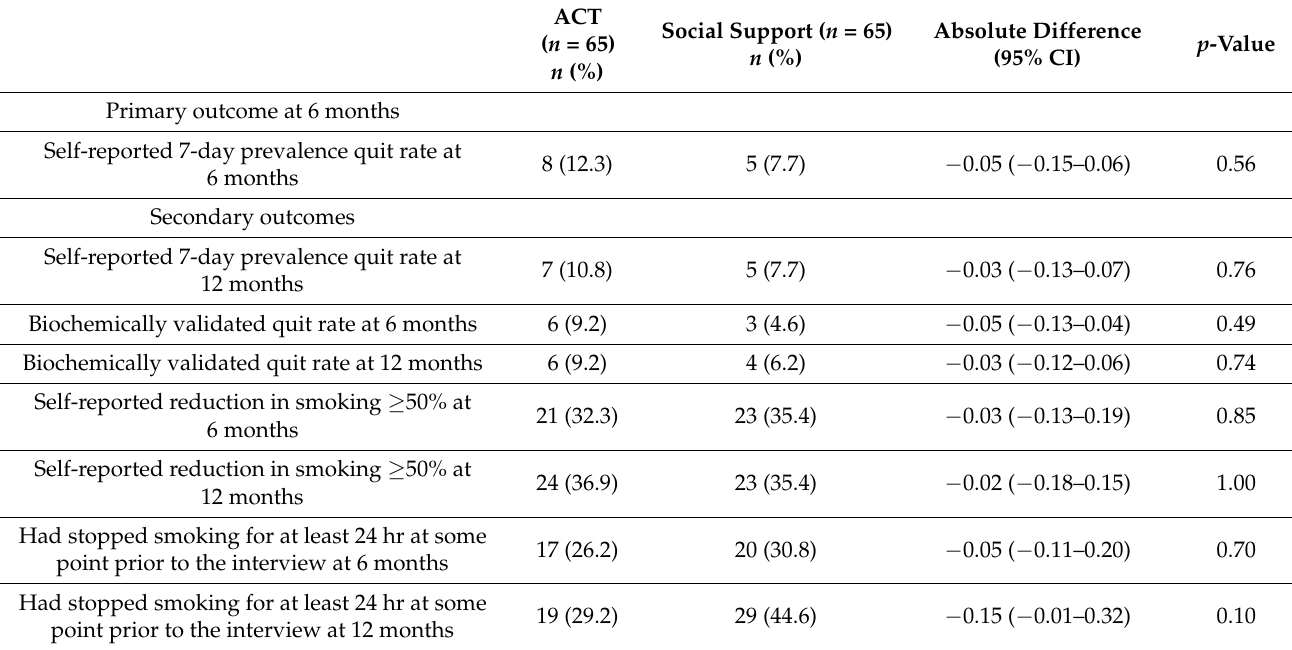
Table 2. Abstinence from cigarette smoking, reduction in smoking at the 6- and 12-month follow-ups and quit attempts within the past 12